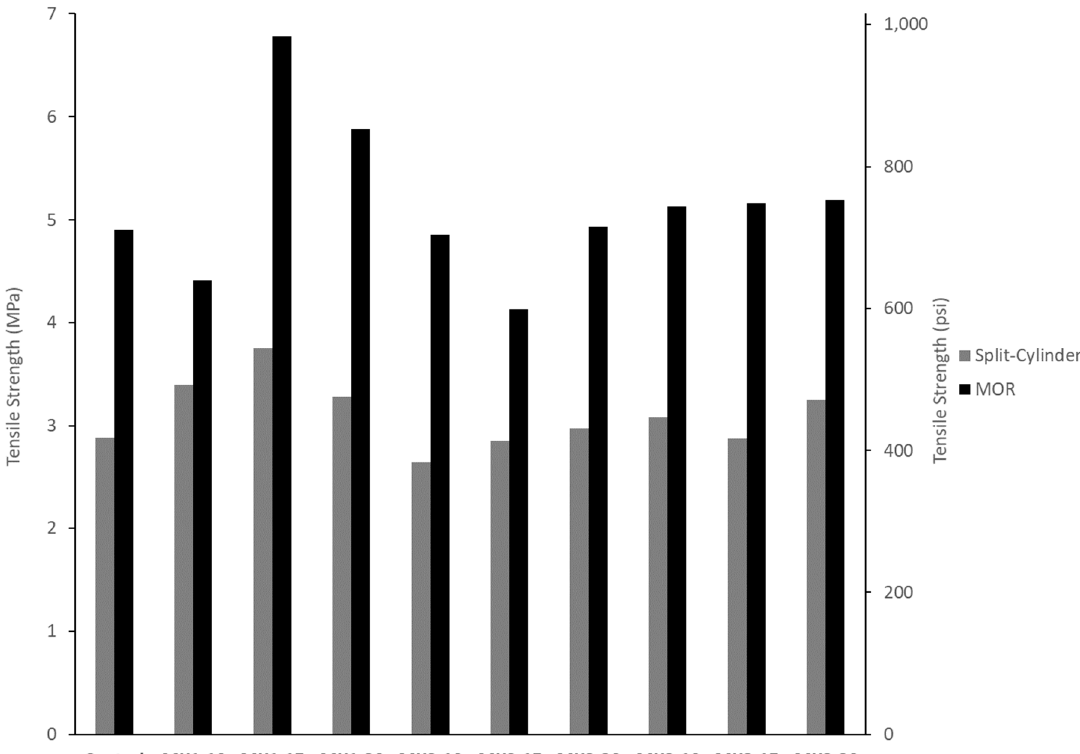
Figure 4. Tensile strength of metakaolin concretes as measured by split-cylinder tension and MOR.